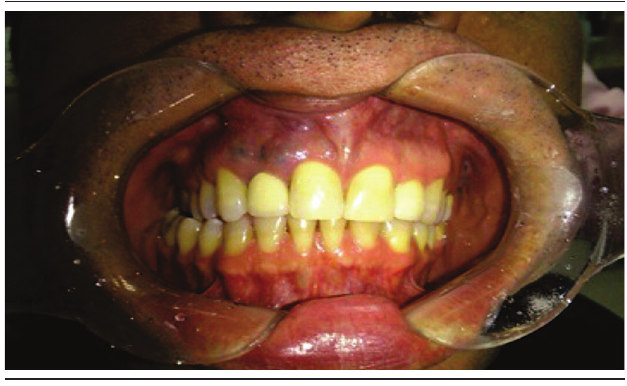
figura 1 − Aspecto